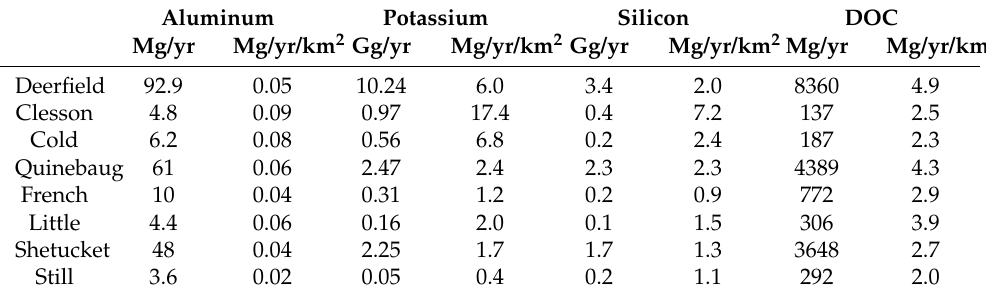
Table 3. Watershed major elements and dissolved organic carbon (DOC) annual export and normal- ized annual export